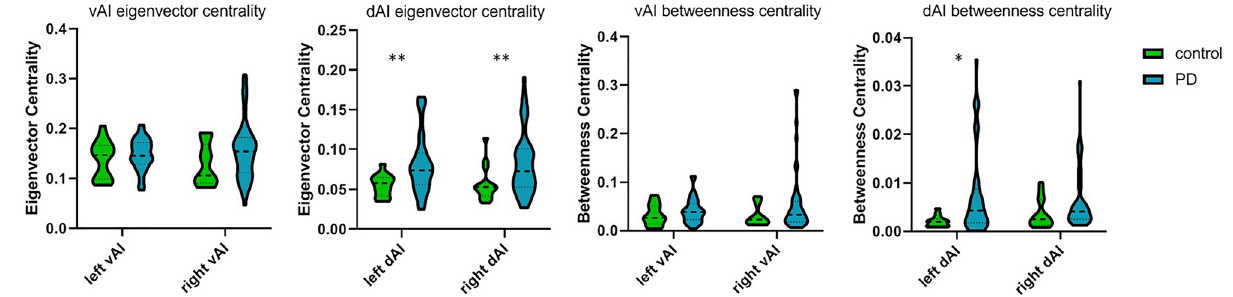
Figure 1. Group differences in eigenvector centrality and betweenness centrality. PD patients showed significantly higher left and right dAI eigenvector centrality and higher left dAI betweenness centrality than controls. vAI = ventral anterior insula; dAI = dorsal anterior insula. *p < 0.05 ** p < 0.01 after Bonferroni